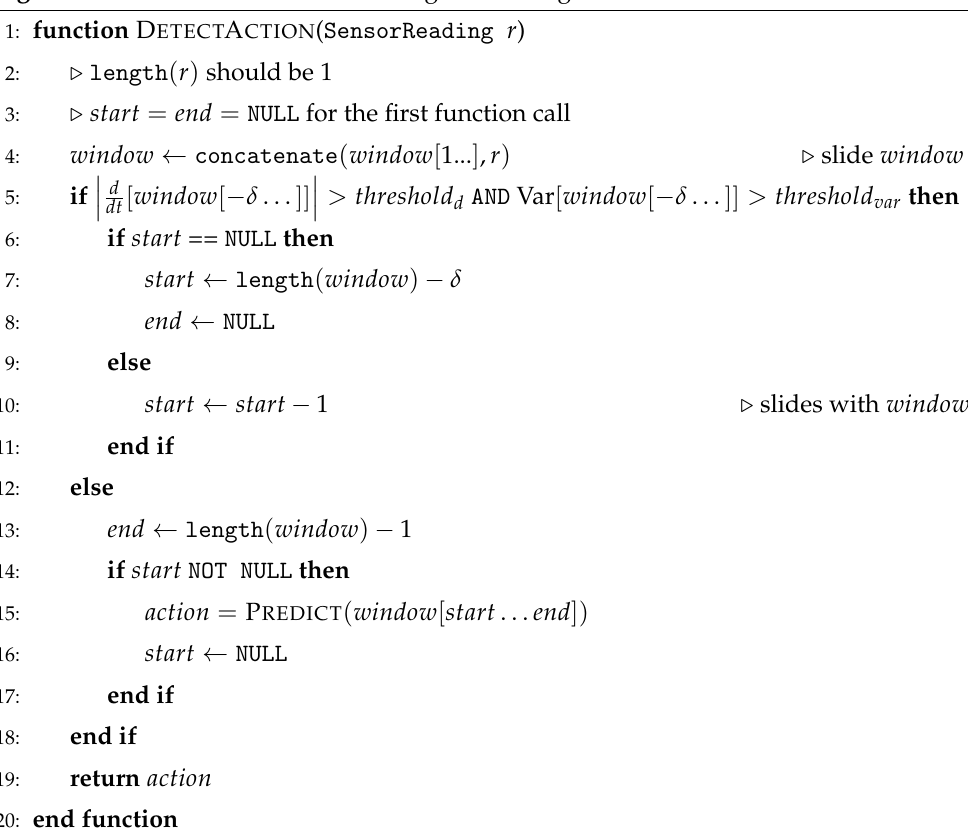
Algorithm 1 Definition of the real-time gesture recognition